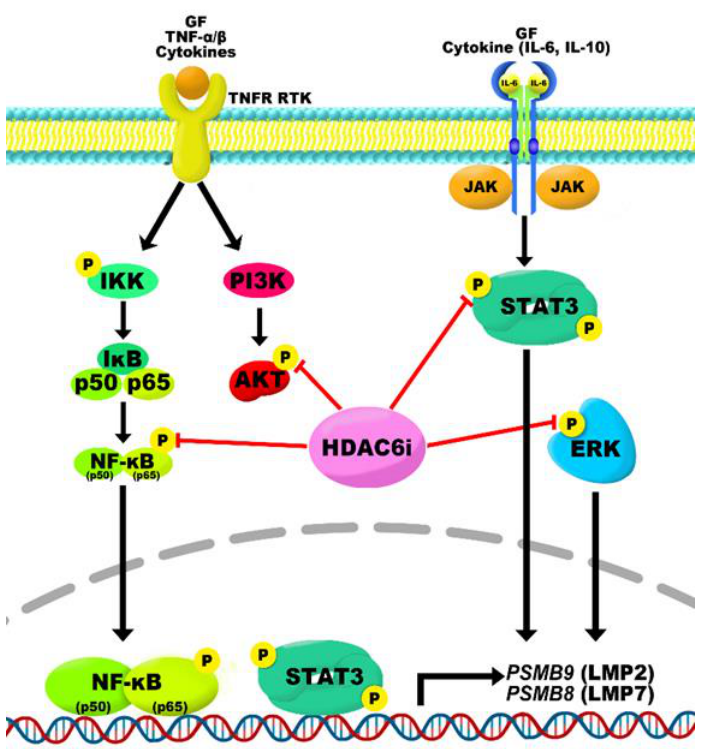
Figure 8. Working model for HDAC6 inhibitor and PI for overcoming BTZ resistance of MM. HDAC6 inhibition by A452 synergize with BTZ or CFZ to inhibit the activation of NF-κB and STAT3, resulting in decreased expressions of LMP2 and LMP7. Additionally, combination treatment of A452 and BTZ or CFZ synergistically inactivates the AKT and ERK MAPK pathways. Combining A452 with BTZ or CFZ leads to synergistic cancer cell growth inhibition and viability decreases. This combination induces apoptosis and enhances PI sensitivity in the BTZ-resistant MM